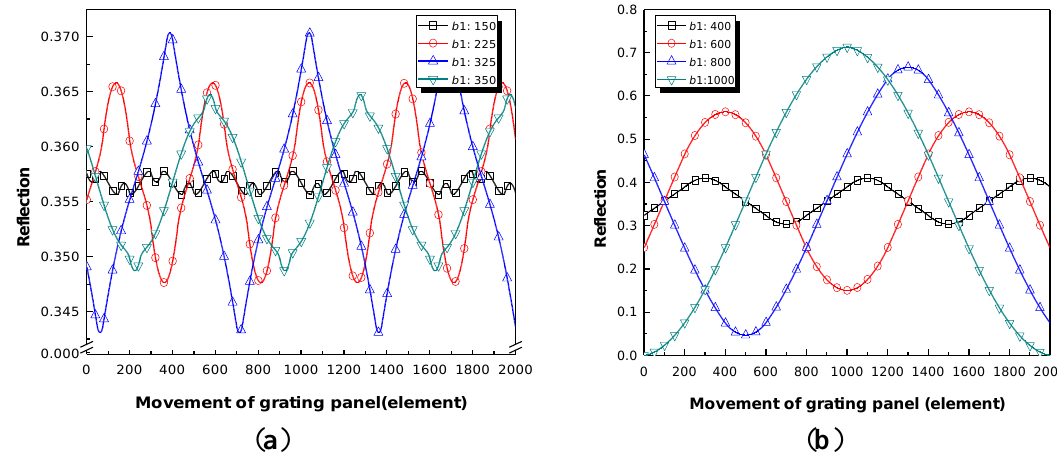
Figure 4. Variations in the reflective light depending on b 1 when m = 1 (case 1). ( a ) Less than 400 elements ( b 1); ( b ) More than 400 elements ( b 1).